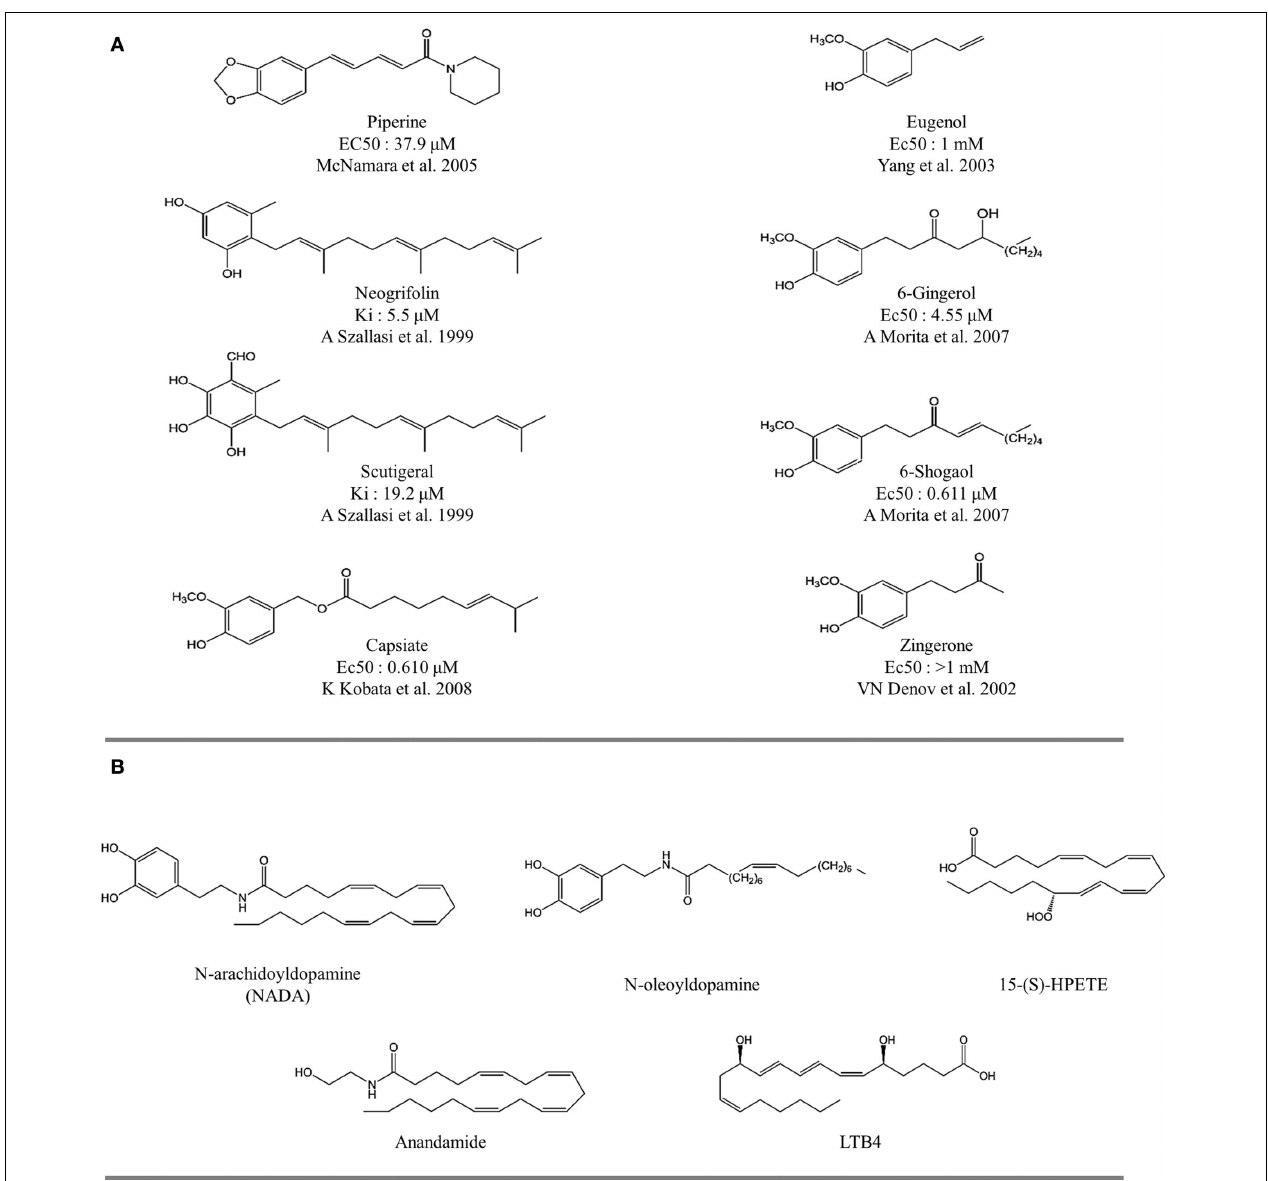
FIGURE 3 | The structure of natural and endovaniloids. (A) Natural compounds with agonist activity on TRPV1 receptors. Figure indicates the affinity for specific 3 [H]-resiniferatoxinbindingsitesinratspinalcord(SzallasiandBlumberg,1999). (B)